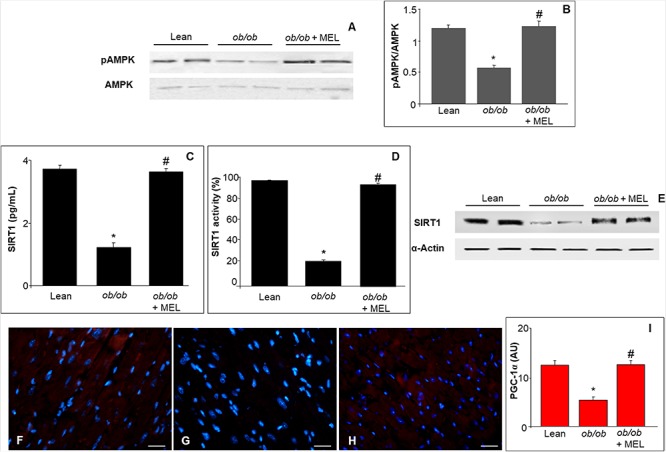
Representative western blot showing expression of pAMPK and AMPK in heart (A) of lean, ob/ob mice, and ob/ob mice supplemented with melatonin and the AMPK/pAMPK ratio as shown by relative densitometry (B). The graphs summarize heart SIRT1 protein level (C) and activity (D). Representative wester blot showing SIRT1 expression in heart of lean, ob/ob mice and ob/ob mice supplemented with melatonin (E). Immunofluorescence photomicrographs of PGC-1α expression in hearts of lean (F), ob/ob mice (G), and ob/ob mice supplemented with melatonin (H). Scale bar: 20 μm. The graph (I) summarizes the PGC-1α immunomorphometrical measurement. *p≤0.05 vs lean mice and #p≤0.05 vs ob/ob mice. AMPK, AMP-activated protein kinase; MEL, melatonin; pAMPK, phosphoAMP-activated protein kinase; PGC-1α, peroxisome proliferator activated receptor gamma coactivator-1alpha; SIRT1, sirtuin1.